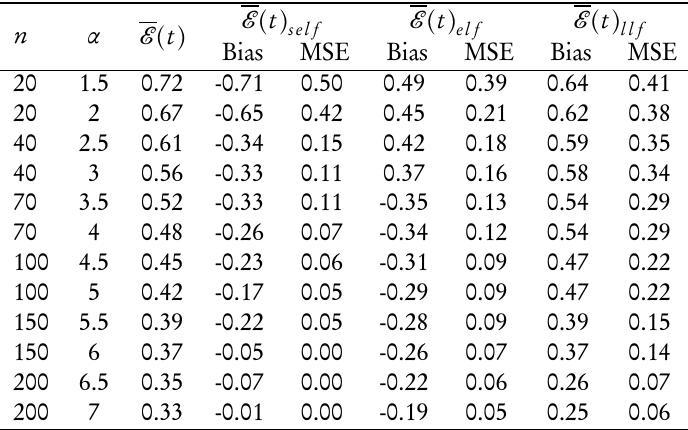
The bias and MSE Lindley approximation method for Bayes estimators of (cid:69) ( t ) using c = 2 and h = 2